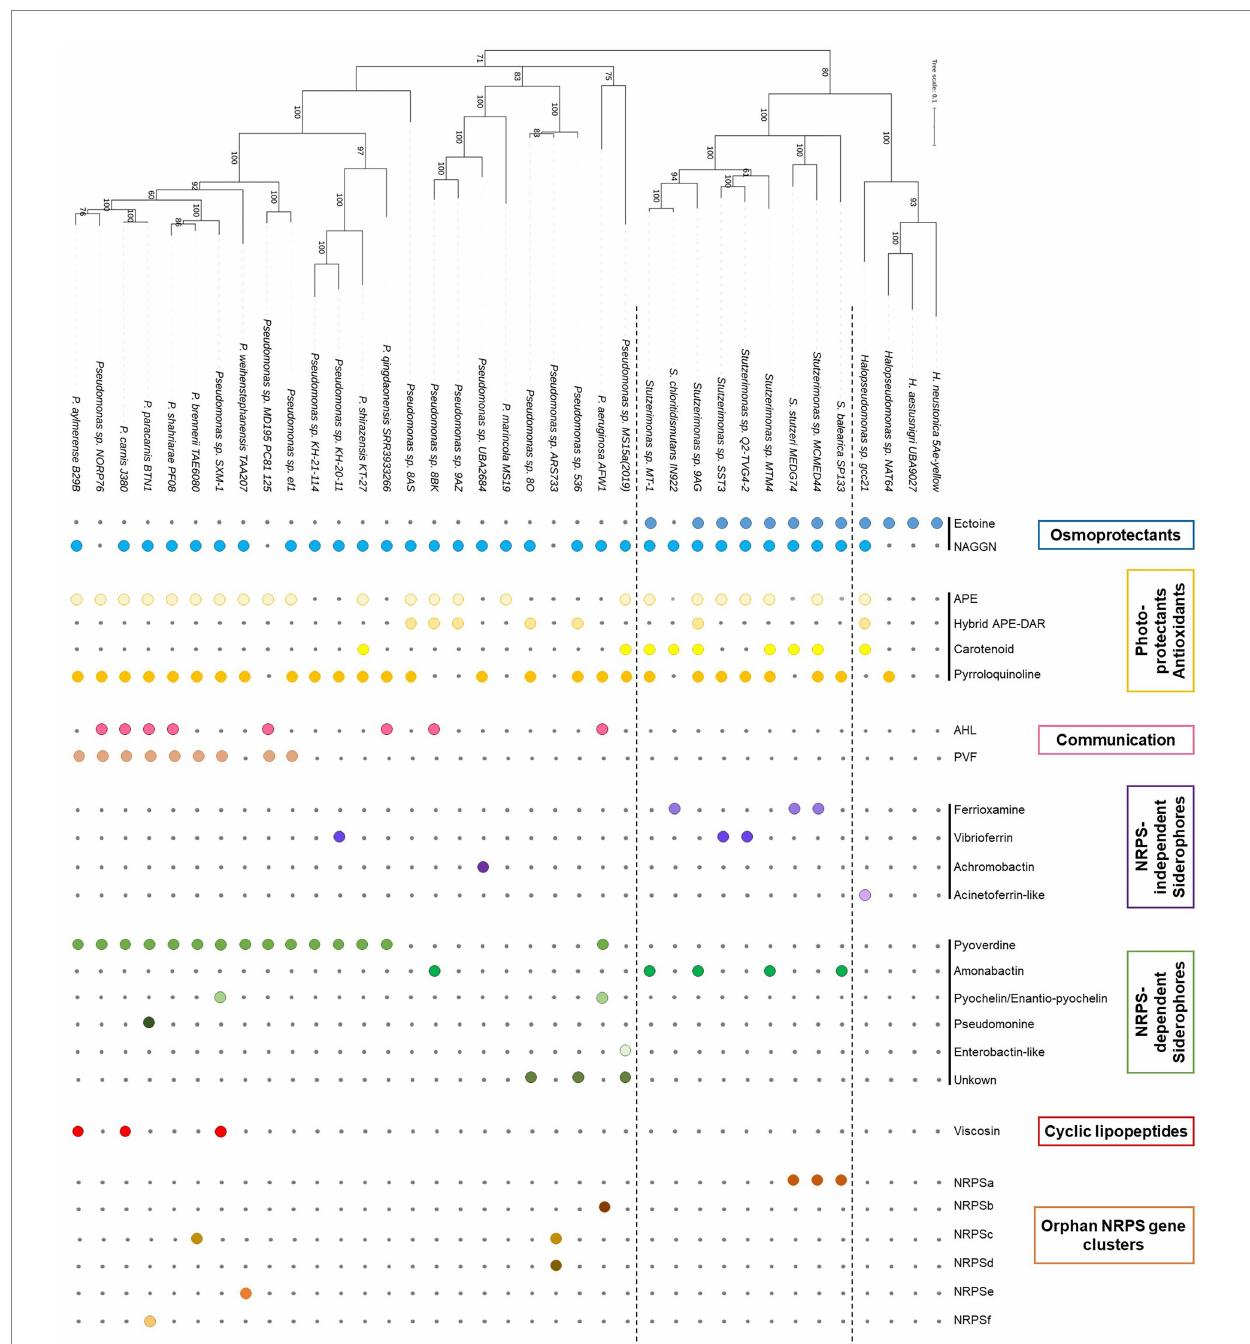
FIGURE 2 Genes and clusters involved in secondary metabolites production. The presence of a gene/cluster is symbolized by a colored circle, while the absence is indicated by a grey dot. NRPS, Non-ribosomal peptide synthetase.